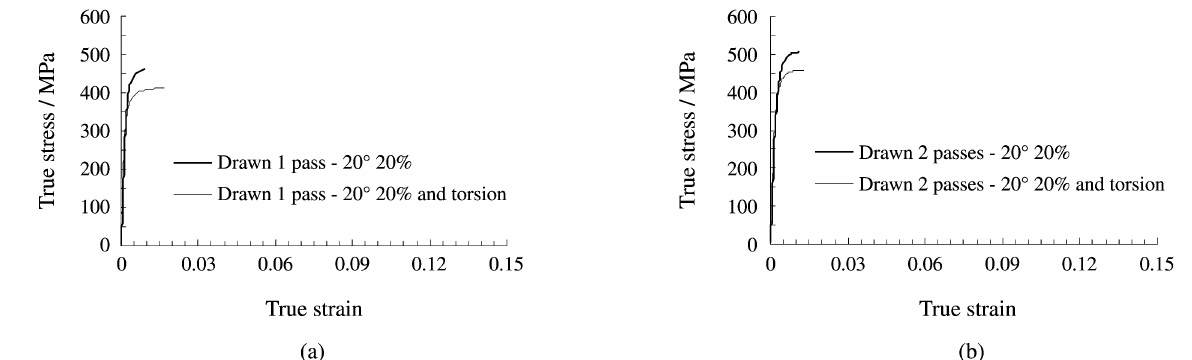
Figure 5. Effect of cyclic torsion on the hardening behavior of drawn (semi-angle 20° and reduction in area of 20%) samples: (a) 1 pass and (b) 2 passes.